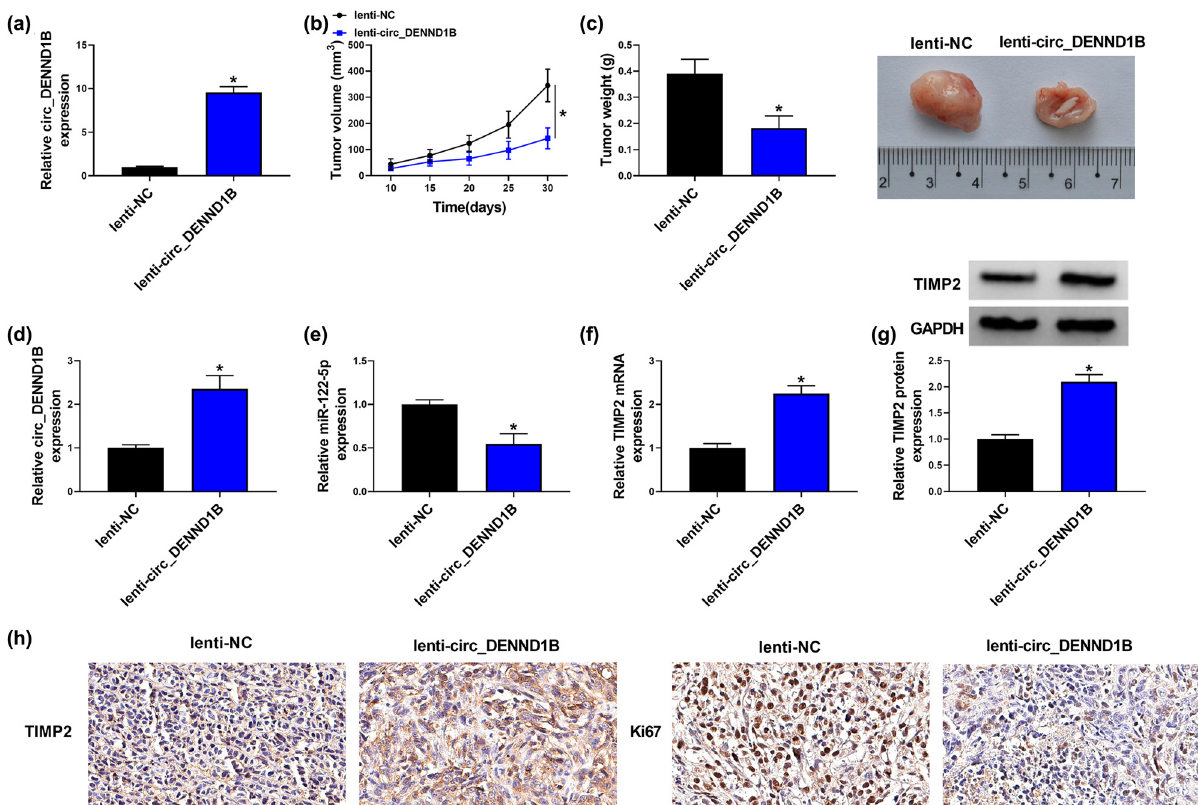
Figure 7: Overexpressed circ_DENND1B inhibits tumor growth in vivo . ( a ) qRT - PCR detected the expression of TIMP2. ( b and c ) Tumor volume and weight after circ_DENND1B overexpressed in vivo . ( d – f ) qRT - PCR detected the expression of circ_DENND1B, miR - 122 - 5p and TIMP2. ( g ) Western blot detected the level of TIMP2 protein. ( h ) IHC detected the positive cells rate of TIMP1 and Ki67. * P <